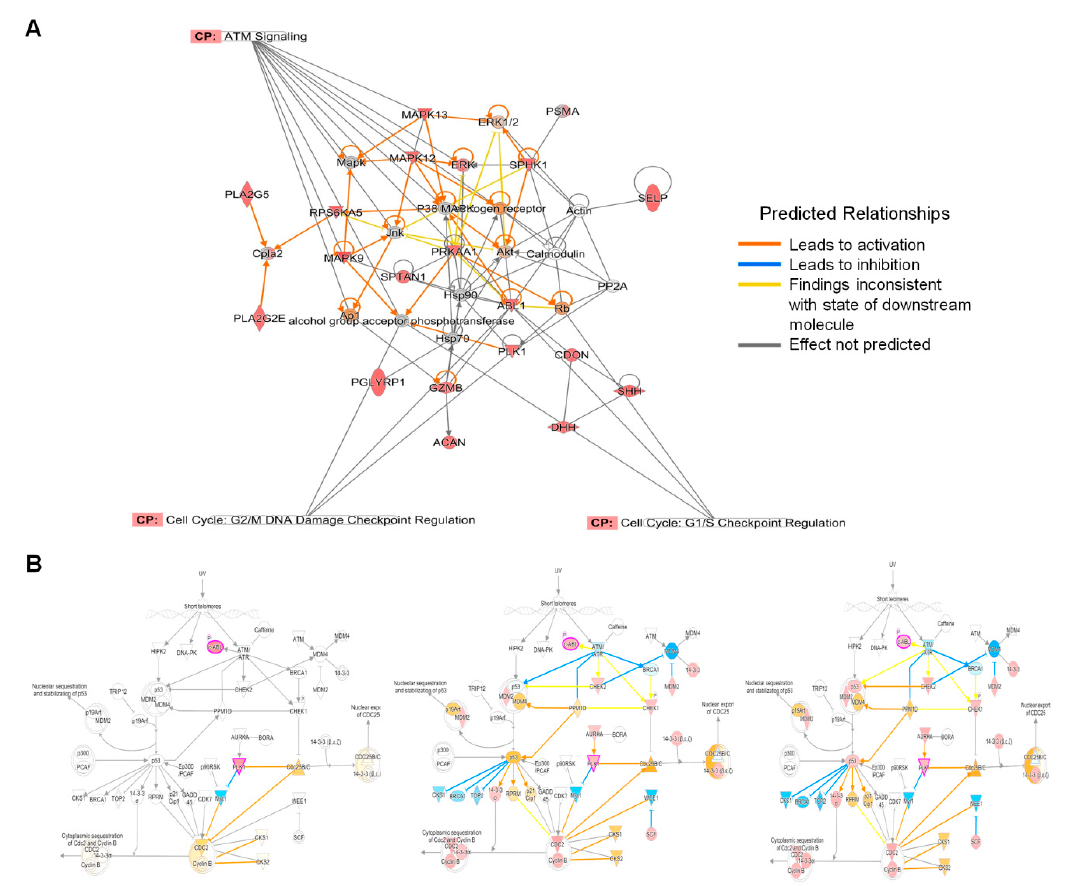
Figure 4. Interactions between network molecules and DNA damage checkpoint pathways. ( A ) Links between top disease and function networks at 12 hpi and immune checkpoint signaling pathways. ( B ) Changes in activation of DNA damage checkpoint signaling pathway across all three time points of ( i ) 12, ( ii ) 24 and ( iii ) 48